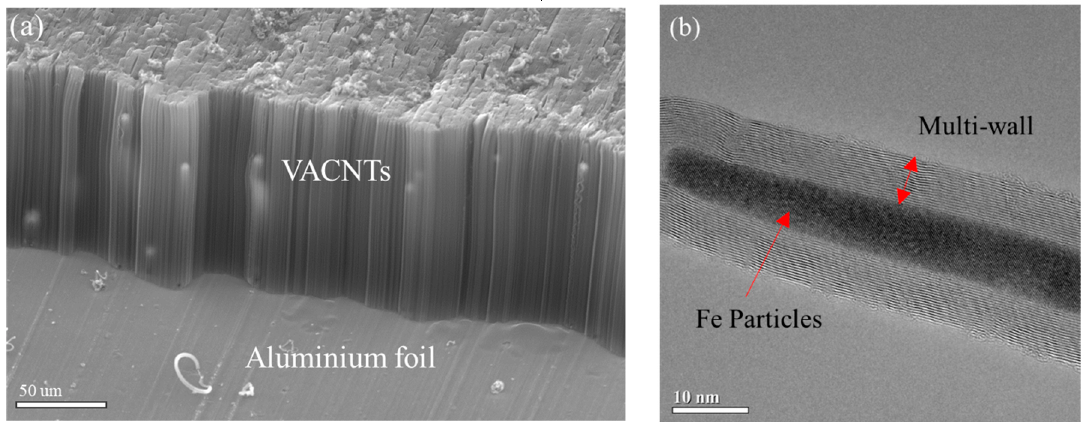
Figure 2. ( a ) Scanning electron microscopy (SEM) image of the aluminum–VACNTs composites from a 45° angle; ( b ) transmission electron microscopy (TEM) image shows Fe particles along the length of the carbon nanotube (CNT).